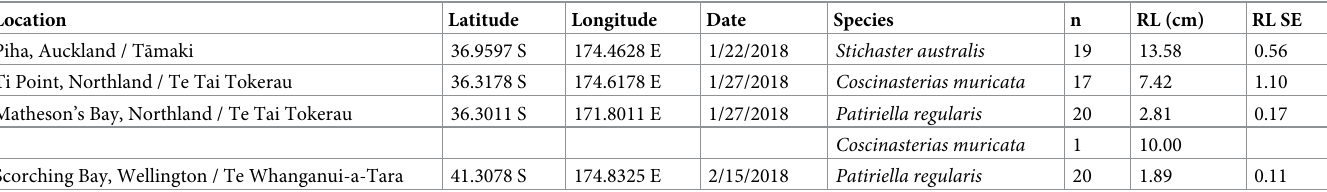
Samples collected at Ti Point were collected subtidally by SCUBA Diver, while those collected elsewhere were collected intertidally. RL = Ray length, SE = Standard